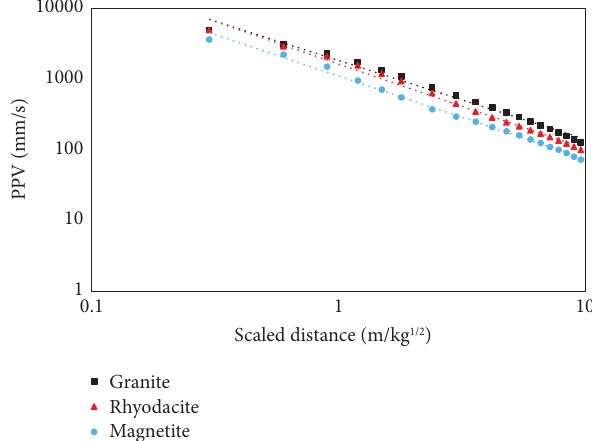
Figure 14: The peak particle velocity versus the scaled distance for three materials with different natural frequencies.